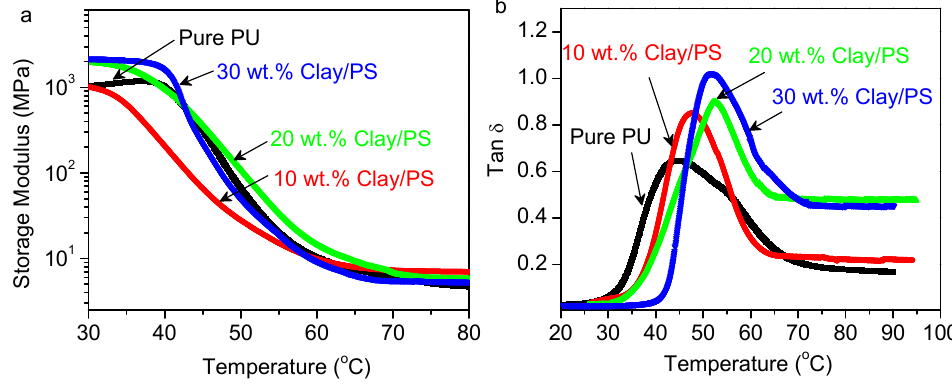
Figure 6. DMTA characterization on T of nanoclay based SMP composites (a) Storage trans modulus versus temperature curves; (b) Tan δ versus temperature